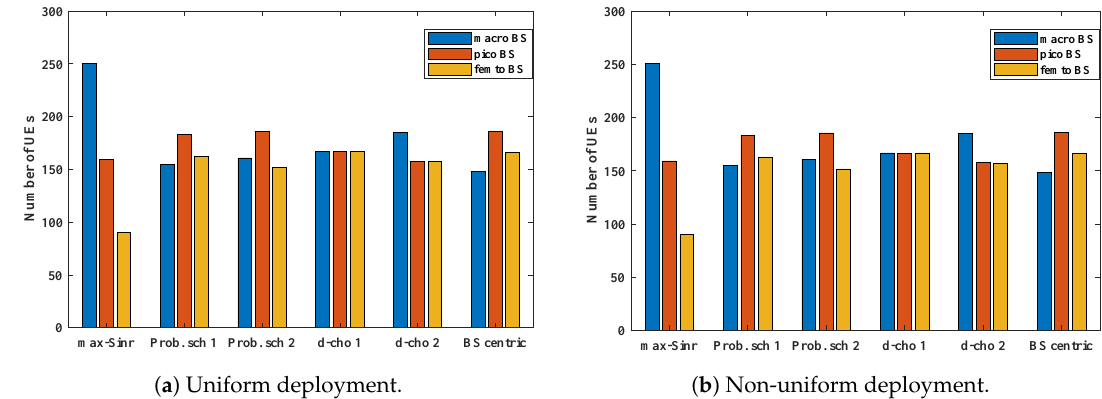
Figure 6. UE share for different association schemes in different deployment